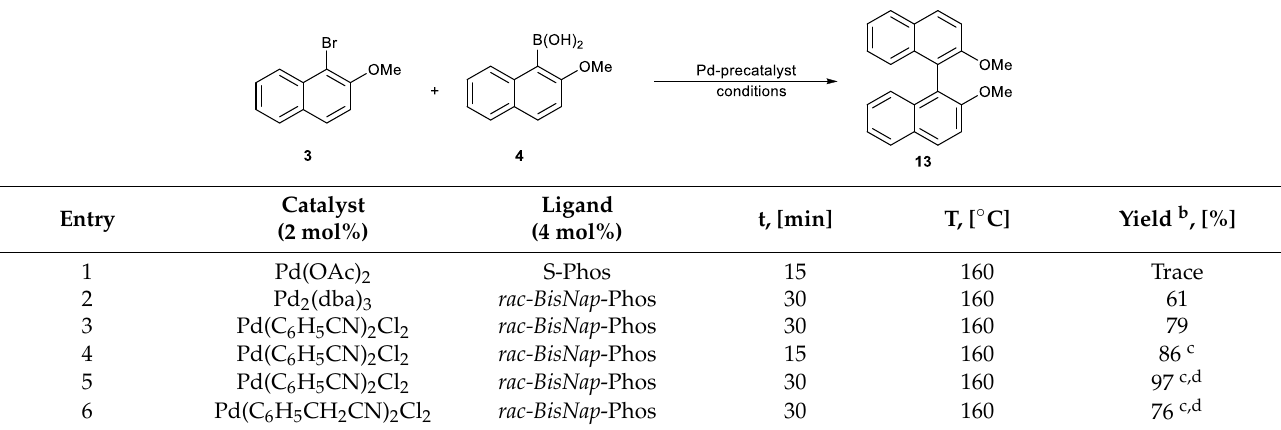
Table 3. Synthesis of 13 under microwave conditions a .